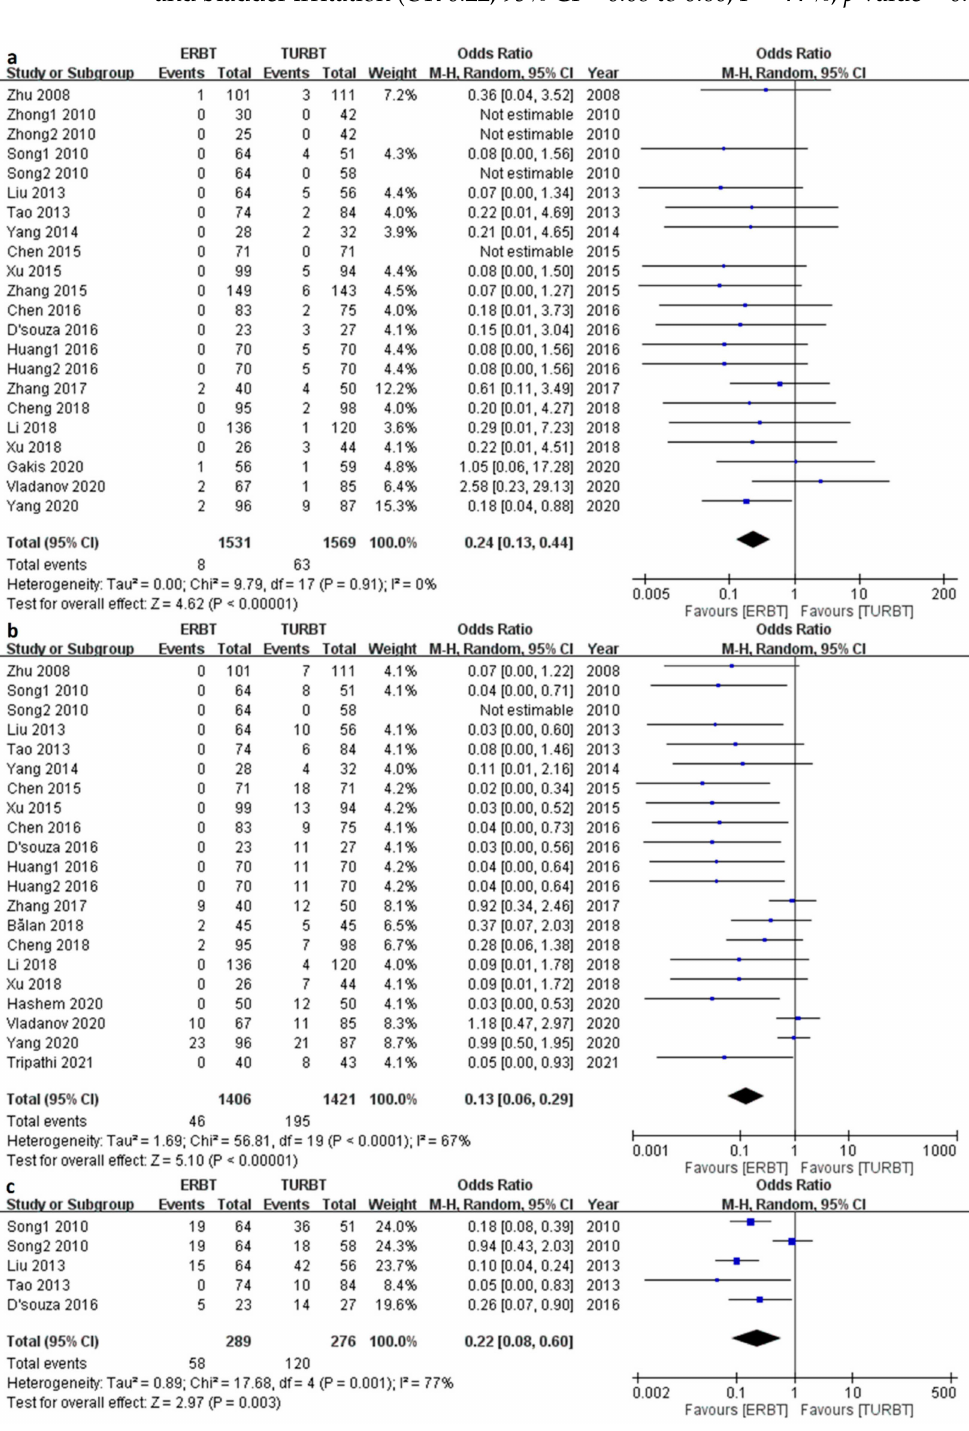
Figure 5. The forest plot of complications. ( a ) The forest plot of bladder perforation. ( b ) The forest plot of obturator nerve reflex. ( c ) The forest plot of bladder